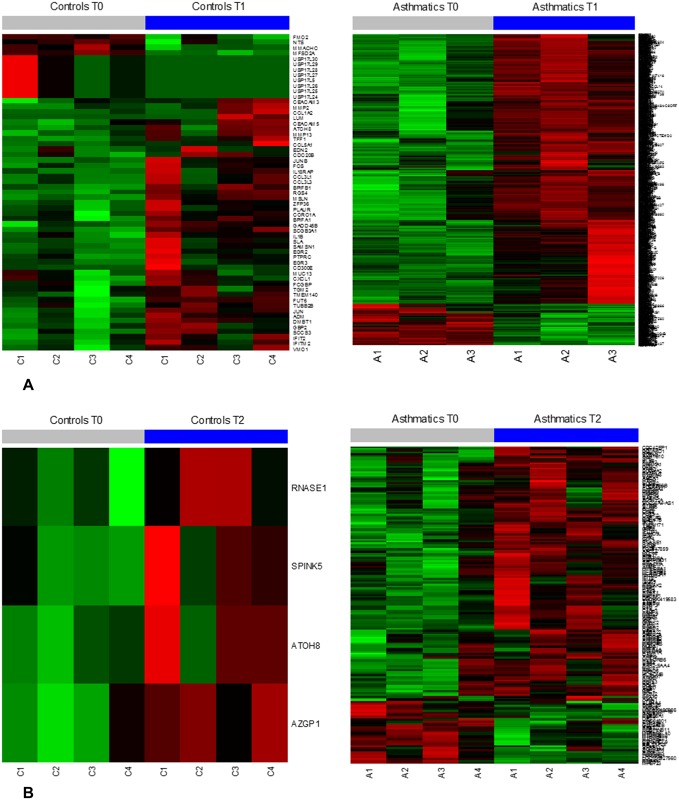
A. Heat map illustrating gene dysregulation in controls (left) and asthmatics (right) at T1 versus T0. The baseline samples of one asthmatic and one control patient were not of sufficient quality and were not included in analysis. The sample from T1 of one asthmatic was not of sufficient quality and was also excluded. B. Heat maps illustrating gene dysregulation in controls (left) and asthmatics (right) at T2 versus T0. The normalized RNA-seq raw counts for SPINK5 in controls at baseline and at T2 ranged from 2.6 to 35.3 and are reflected in the heat map with green representing lower values and red representing higher values.